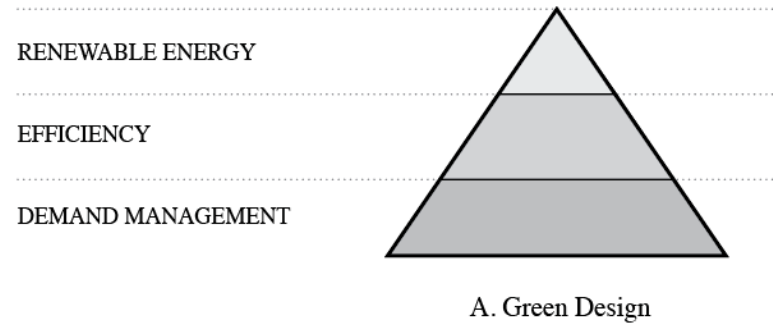
Figure 3. Conceptual diagram of the carbon reduction elements of Green Design.